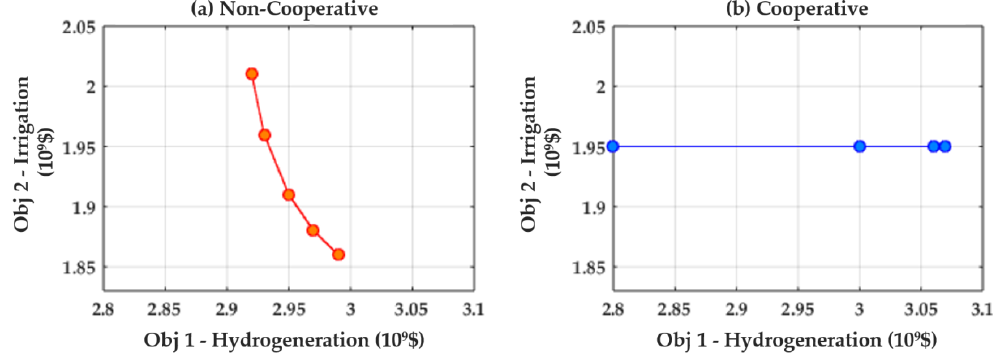
Figure 6. Trade-off between annual hydro-generation and irrigation benefits. Optimal Pareto Front of two objective functions over the optimization period for: ( a ) non-cooperative system management (Non-Coop), and ( b ) cooperative system management (Coop) of the Eastern Nile Basin, under normal hydrologic conditions. Table 2. Summary of financial returns comparing cooperative and non-cooperative management scenarios. Sudan Egypt Coop. Non-Coop. Coop. Coop. Coop.